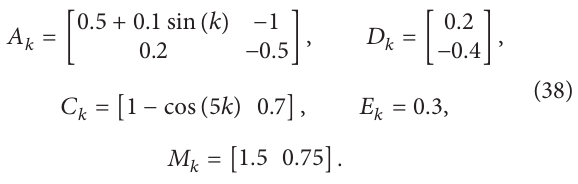
Figure 1: The state 𝑥 1 𝑘 and its